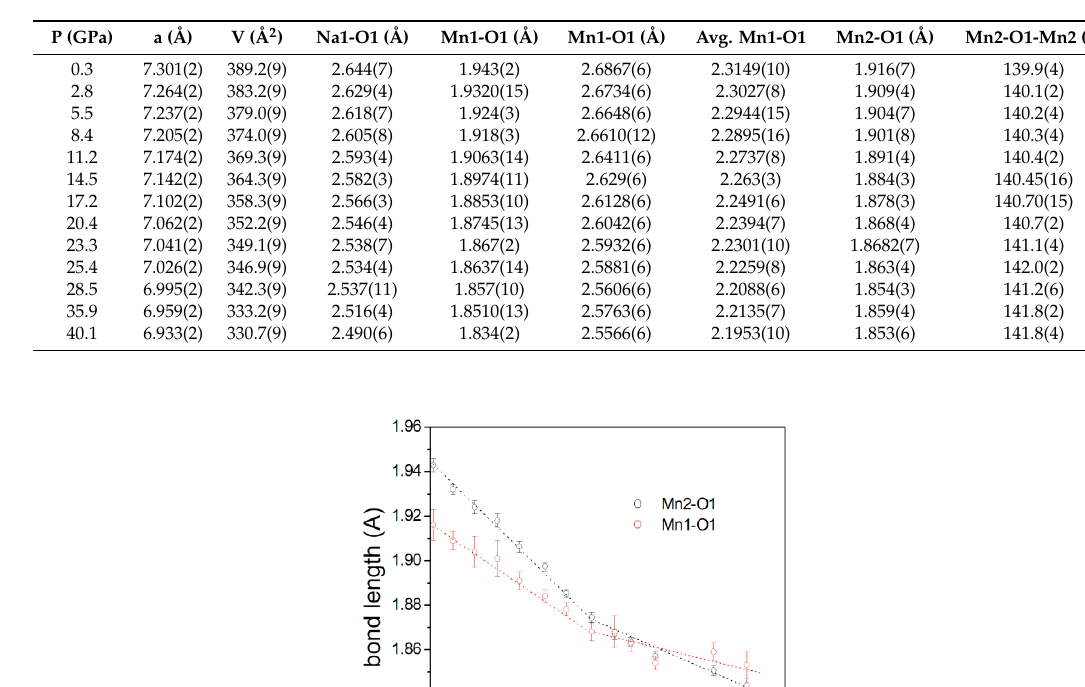
Figure 6. NaMn 7 O 12 cell volume vs. pressure. Fittings were performed using the Birch–Murnaghan equation. B is the bulk modulus, and B’ is set to 4. A change in the compressibility is observed at about 16 GPa. Error bars are smaller than the corresponding symbols. Table 1. Lattice parameter, cell volume and selected bond lengths of NaMn 7 O 12 at different applied pressures.